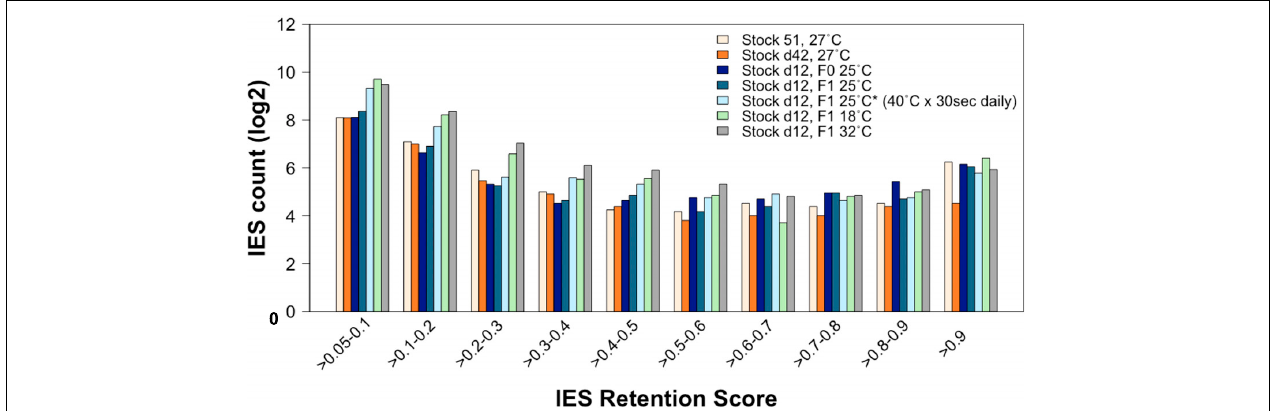
FIGURE 6 | The rate of incomplete IES excision is affected by the ecological conditions to which the parental generation is exposed during vegetative life. Compared to lines that have undergone autogamy at 25–27 ◦ C, the count (in log2) of incompletely excised IESs is larger for several IRS classes not only in cells that have undergone autogamy at 18 and 32 ◦ C but also in cells that have undergone autogamy at 25 ◦ C but have been grown at 25 ◦ C and exposed daily to 40 ◦ C for 30